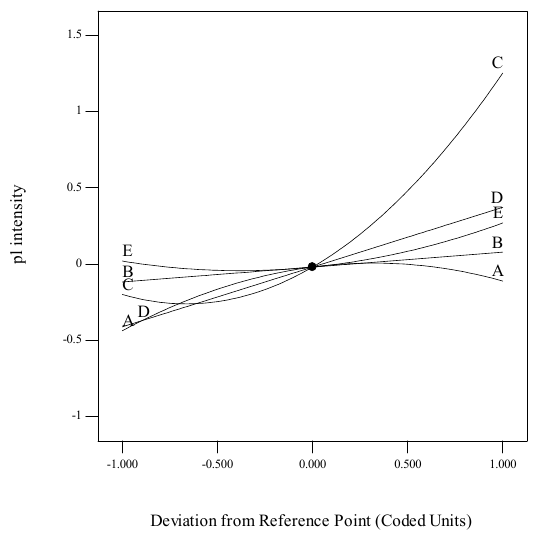
Fig. 4. Perturbation plots of pl Fig. 4: Perturbation plots of pl intensity